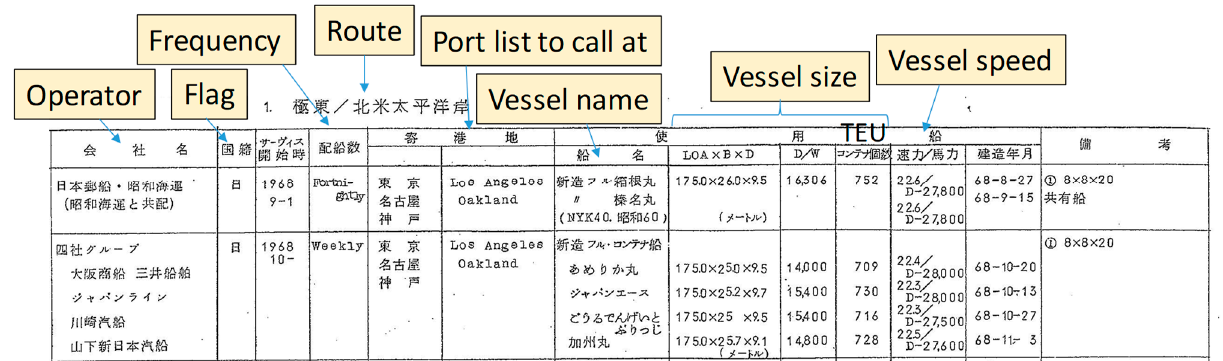
Figure 1. Sample of NYK report (issued in February 1969).